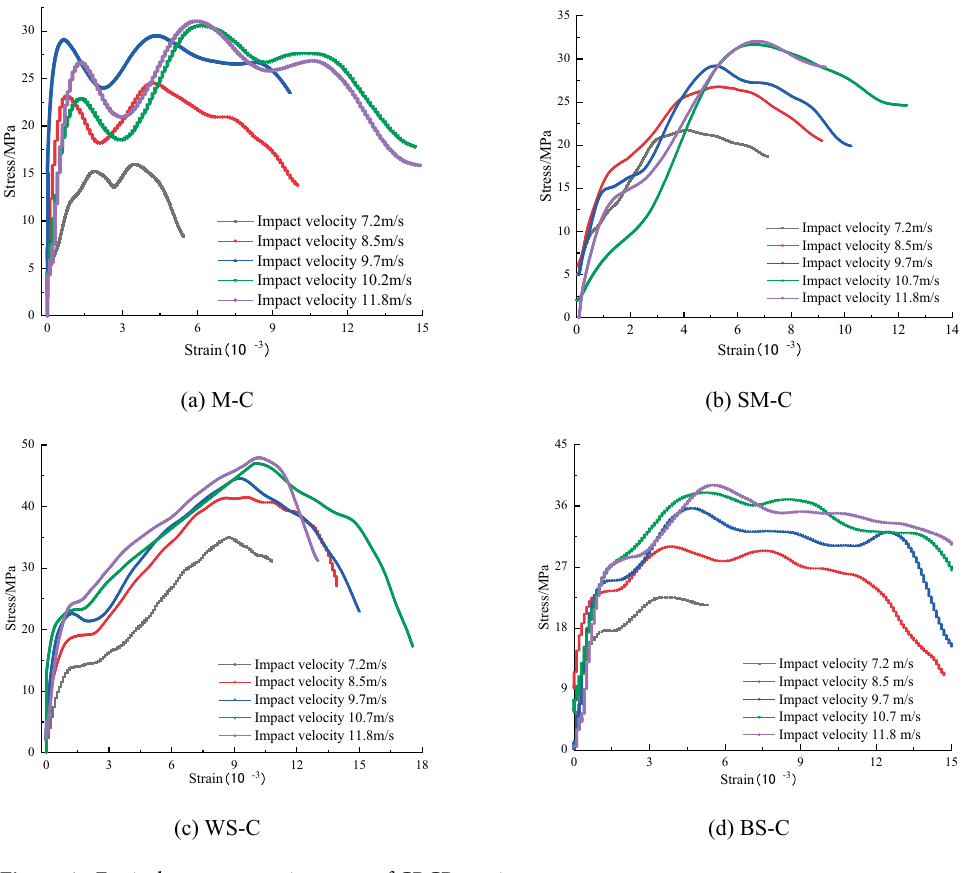
Figure 6. Equivalent stress–strain curves of CRCB